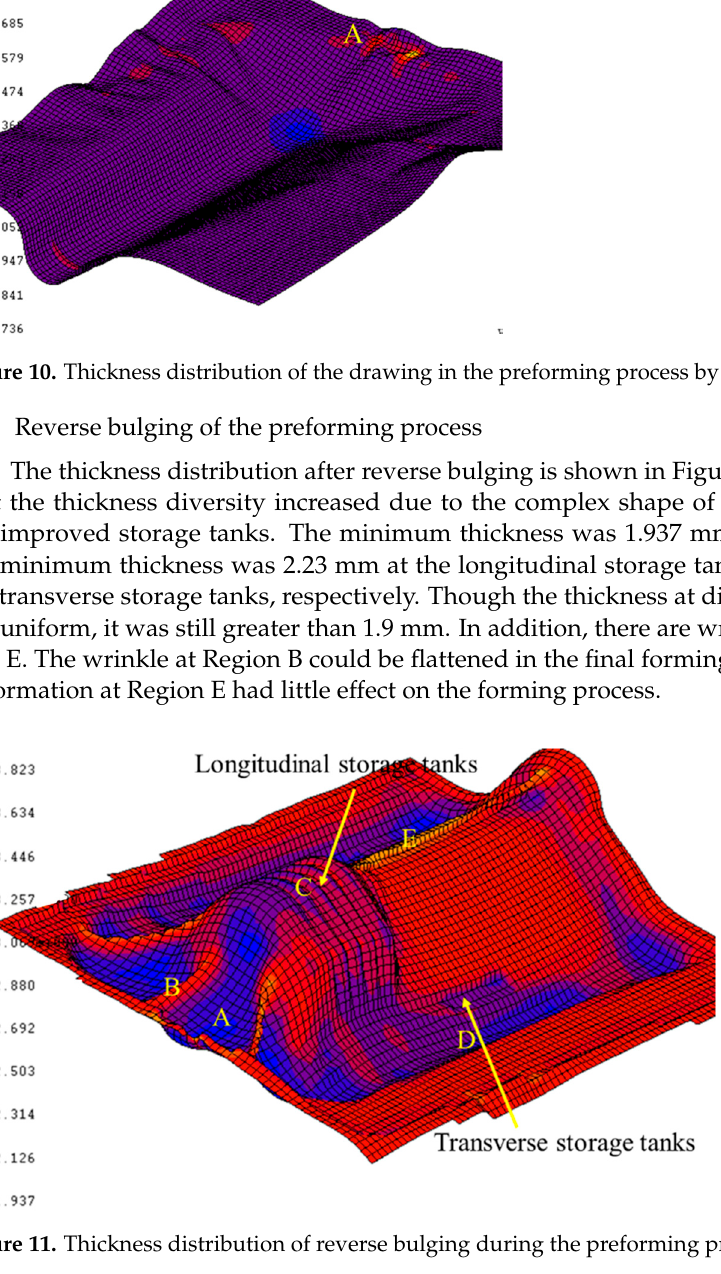
8 of 15 Figure 9. Male die of the preforming process: ( a ) optimized model; ( b ) machined die. (1) Drawing of the preforming process